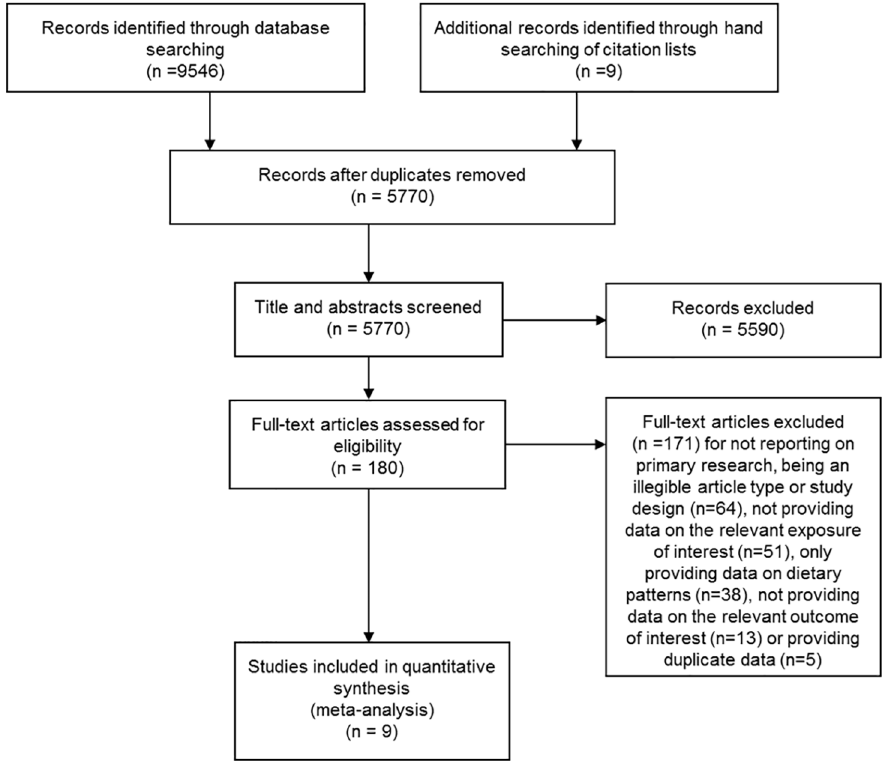
Fig 1. Flowchart of study identification and selection process. All systematic review and meta-analyses methods conducted according to PRISMA guidelines.